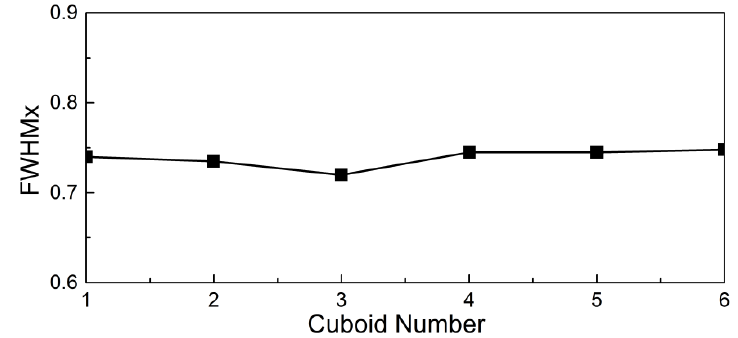
Figure 5. Numerical results of the full-width at half-maximum along the transversal x -axis of the photonic nanojets (PNJ) produced by each cuboid for the optimal case when p = 2.5λ 0 and d y = 120 nm.